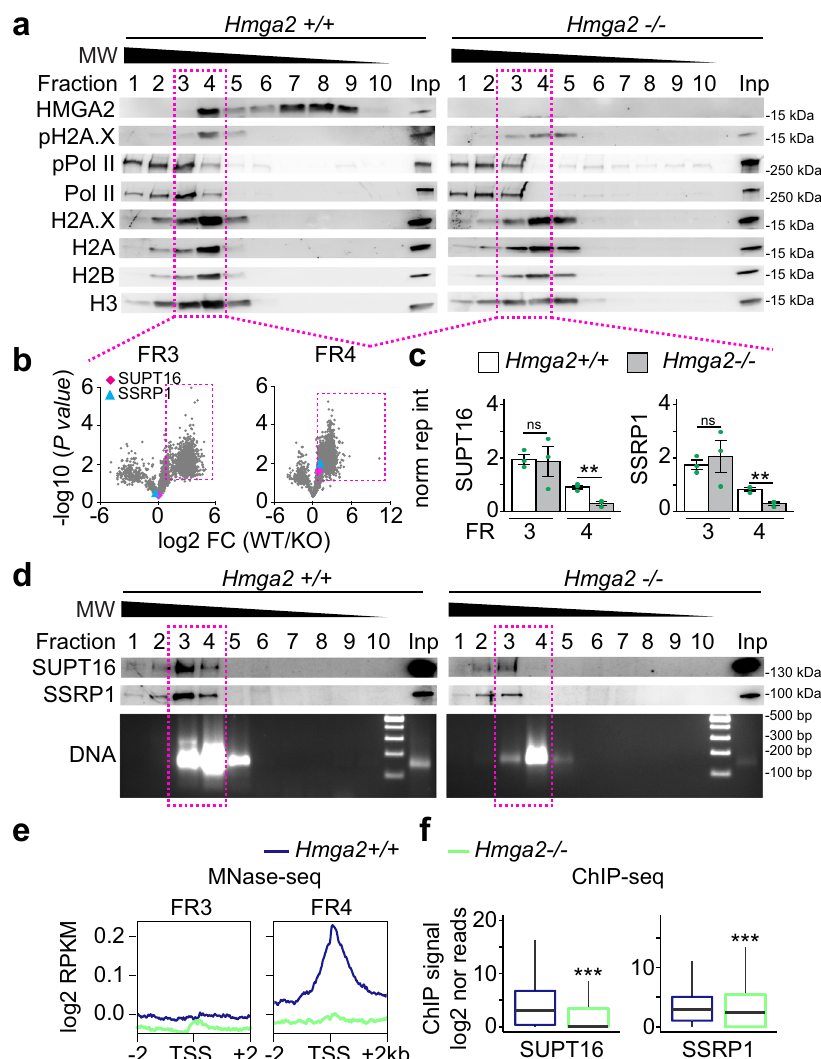
Fig. 4 HMGA2 is required for enrichment of the FACT complex at TSS. a – e Native chromatin from Hmga2 + / + and − / − MEF was digested with micrococcal nuclease (MNase) and fractionated by sucrose gradient ultracentrifugation (SGU). a The obtained fractions were analyzed by WB using the indicated antibodies. Representative images from three independent experiments. MW, molecular weight, kDa, kilo Dalton. Inp, input represents 0.5% of the material used for SGU. Square, fractions selected for further analysis. b Mass spectrometry analysis of proteins in fractions 3 and 4. Volcano plot representing the signi fi cance ( − log10 P -values after one-tailed t -test) vs. intensity fold change between Hmga2 + / + and − / − MEF (log2 of means intensity ratios from three independent experiments). Square, proteins with log2 fold change >1.65. Diamond, SUPT16; triangle, SSRP1. c Bar plots showing normalized reporter intensity of SUPT16 (left) and SSRP1 (right) in fractions 3 and 4 of the SGU in a. Data are shown as means ± s.e.m. ( n = 3 biologically independent experiments); asterisks, P -values after two-tailed t -Test, ** P ≤ 0.01; ns, non-signi fi cant. d Top, WB analysis as in a using antibodies speci fi c for components of the FACT complex. Bottom, DNA was isolated from the fractions obtained by SGU in A and analyzed by agarose gel electrophoresis. Representative images from three independent experiments. Square, fractions selected for MNase-seq. e MNase-seq of fractions 3 and 4 of the SGU in a . Aggregate plots representing the enrichment over input (as log2 RPKM) of genomic sequences relative to the TSS ± 2 kb. f Box plots of ChIP-seq-based SUPT16 (left) and SSRP1 (right) enrichment analysis within the TSS + 0.5 kb of the top 15% candidates in Hmga2 + / + and − / − MEF. Values are represented as log2 of mapped reads that were normalized to the total counts and the input was subtracted. Box plots indicate median (middle line), 25th, 75th percentile (box) and 5th and 95th percentile (whiskers); n = 9522 genes enriched with pH2A.X; asterisks, P -values after two-tailed Mann – Whitney test, *** P ≤ 0.001. See also Supplementary Figs. 2 and 3. Source data are provided as a Source Data fi les 01 and